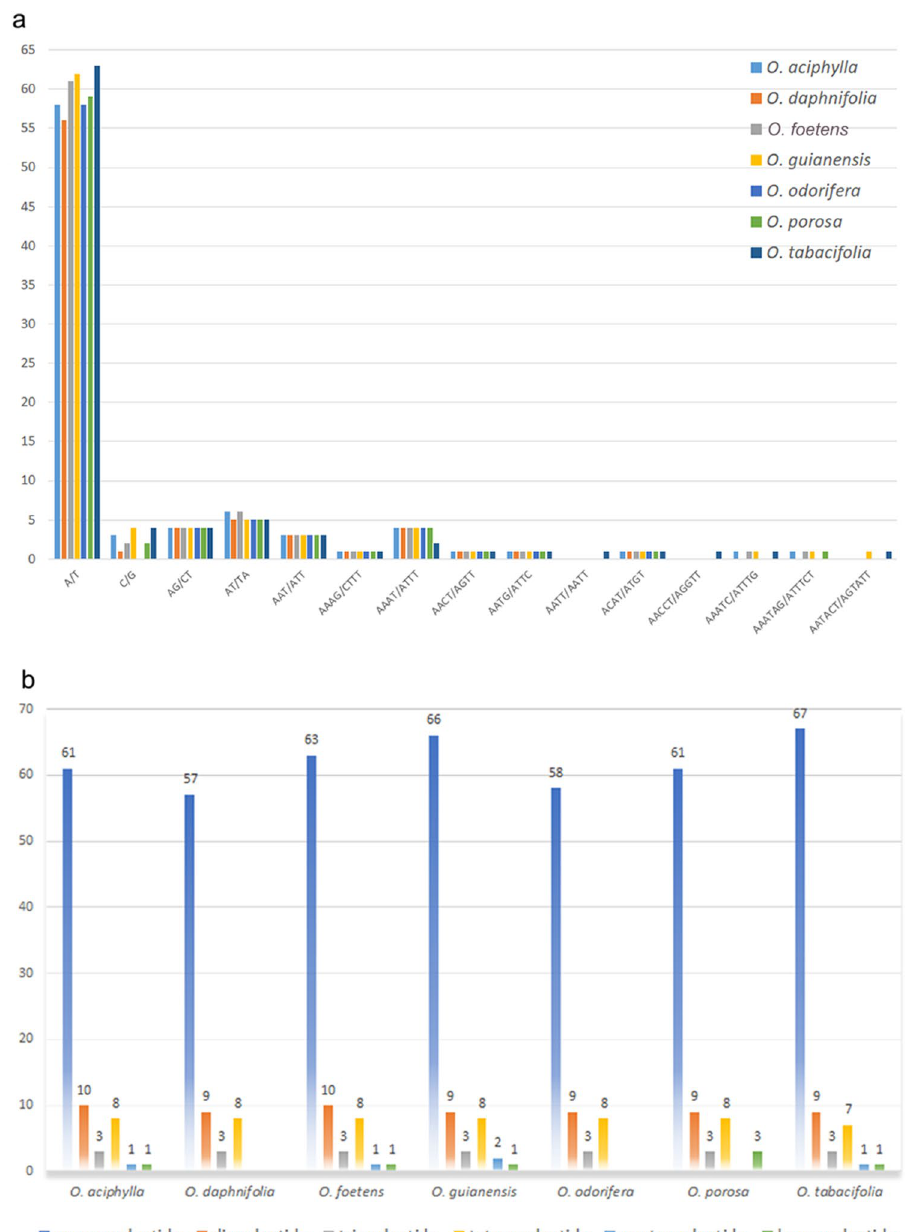
Figure 6. Simple sequence repeats (SSRs) in seven chloroplast genomes of Ocotea . ( a ) Counts of nucleotide repeats; ( b ) counts of mono-, di-, tri-, tetra-, penta- and